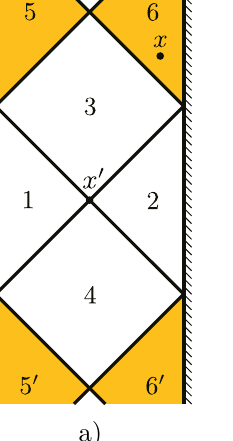
Figure 8 . a): in the Schwarzian limit, one-sided propagators P( x ; x 0 ) and I( x ; x 0 ) are only